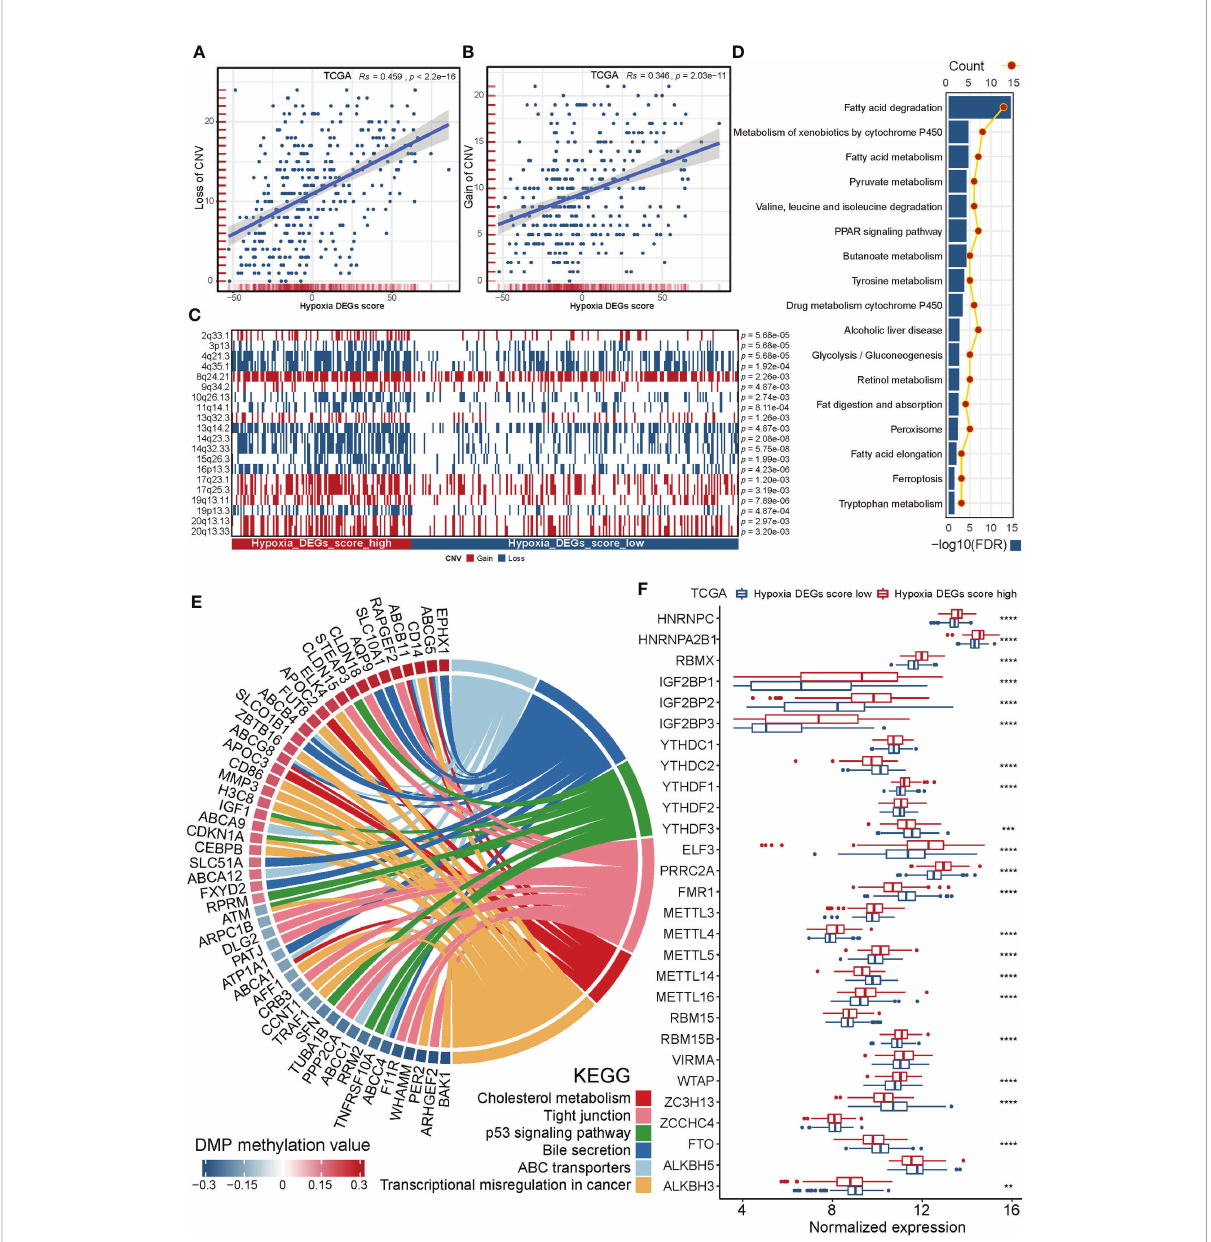
FIGURE 6 Copy number variation, DNA methylation and N6-methyl-adenosine modi fi cation in groups with different hypoxic statuses. (A, B) Scatterplots showing the robust correlation of the Hypoxia_DEGs_Score with loss (A) and gain (B) CNVs according to Spearman ’ s rank correlation analysis. Rs is Spearman ’ s coef fi cient of rank correlation. (C) A heatmap exhibiting the top 20 most signi fi cantly different CNV loci in distinct Hypoxia_DEGs_Score groups. The Fisher test was used to determine the statistical signi fi cance of the differences. Red, deletions; blue, gene number ampli fi cations. (D) Enrichment analysis for the associated genes of 40 signi fi cantly different CNV loci based on KEGG gene sets. (E) Circle diagram showing the enrichment analysis for the targeted genes of DMPs based on KEGG gene sets. FDR< 0.05 for enriched pathways was considered statistically signi fi cant and was shown. Red, increased level of DNA methylation in Hypoxia_DEGs_Score high group vs. low group; Blue, decreased level of DNA methylation. (F) Boxplots showing the expression of 28 N6-methyl-adenosine regulators in groups with different hypoxic statuses. The boxes indicate the median ± 1 quartile, with the whiskers extending from the hinge to the smallest or largest value within 1.5× IQR from the box boundaries. *P < 0.05, **P < 0.01. ***P < 0.001. ****P <